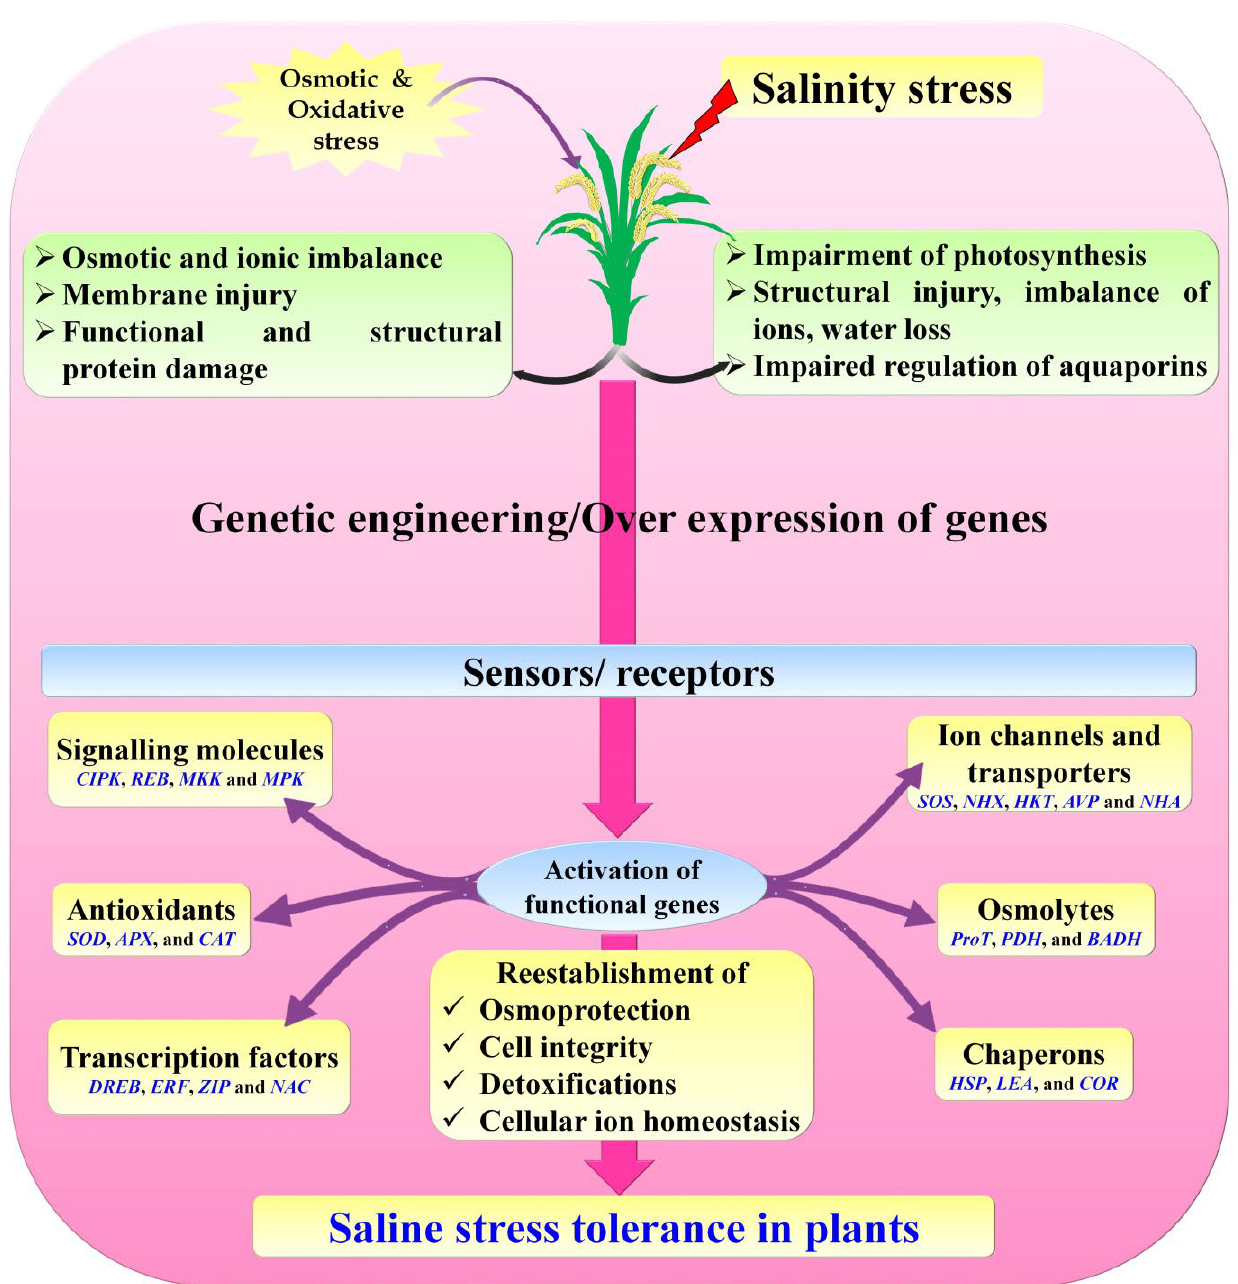
Figure 4. Alleviation of salt stress resistance via genetic engineering/overexpression in rice.